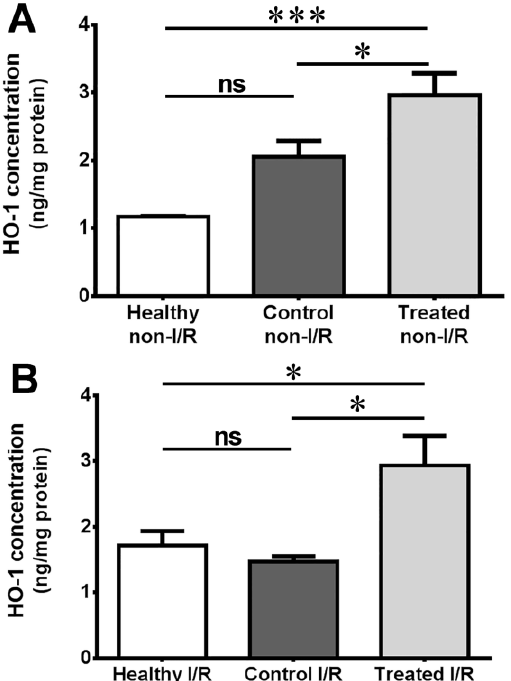
Figure 3. Results of heme oxygenase 1 concentration measurement. ( A ) Non-ischemic/reperfused eyes; ( B ) Ischemic and reperfused eyes. Carried out from the removed bulbi of animals of the different groups, this measurement estimates the amount of heme oxygenase 1 enzyme (ng) per mg (total) protein. Values are mean ± SEM in ng/mg; ns = no significant difference; * p < 0.05; *** p < 0.001.